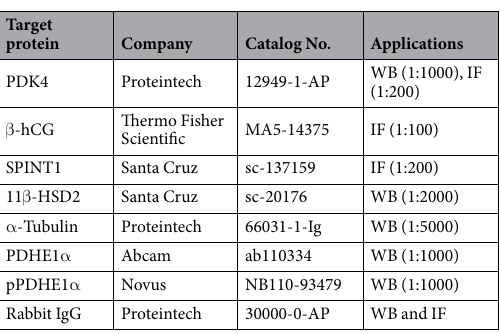
Target protein Company Catalog No.